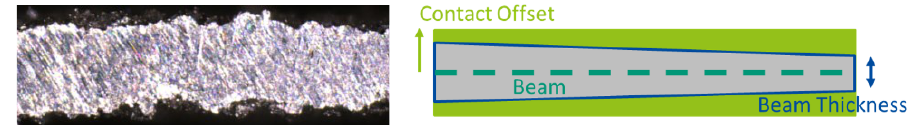
Fig. 4. Cross section of a SLM printed structural component printed out of Scalmalloy and its model equivalent, depicting its solid core encased by an uneven layer of